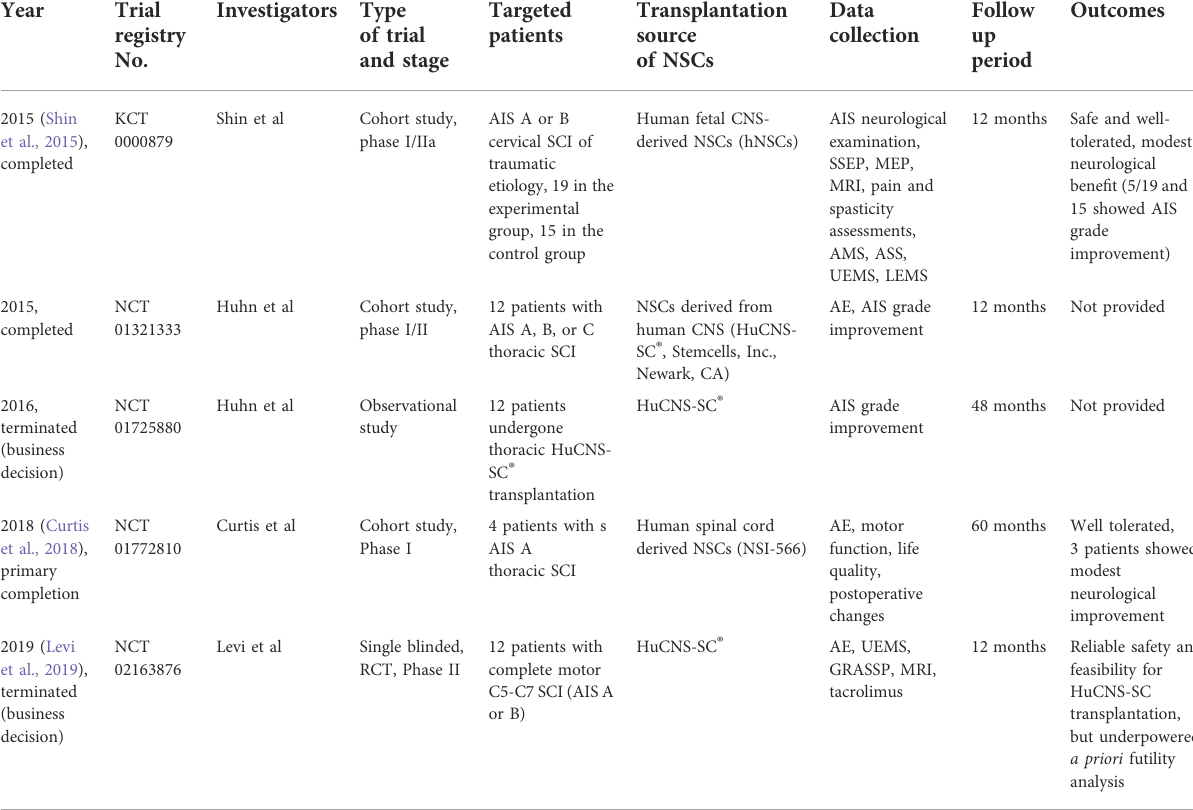
TABLE 1 Summary of outcomes of clinical trials of using NSCs to treat